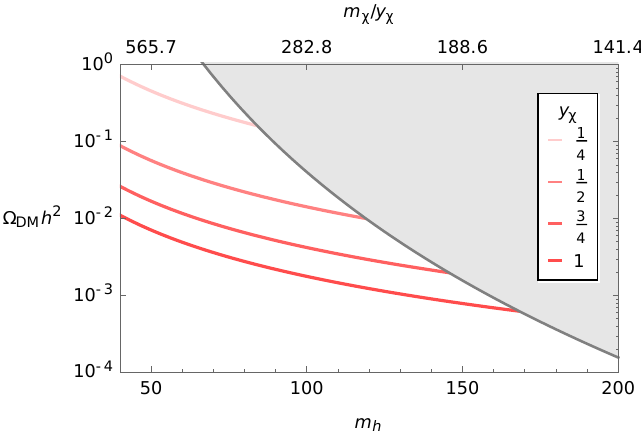
Figure 6 . Example computation of the relic density for model (1.1) with (cid:3) = 200 GeV. In the gray region, m (cid:31) < m h . Here we have considered the relic density of N f = 3 =y (cid:31) fermions with Yukawa D coupling y (cid:31) , such that this result can be compared with the results of the scan in the previous